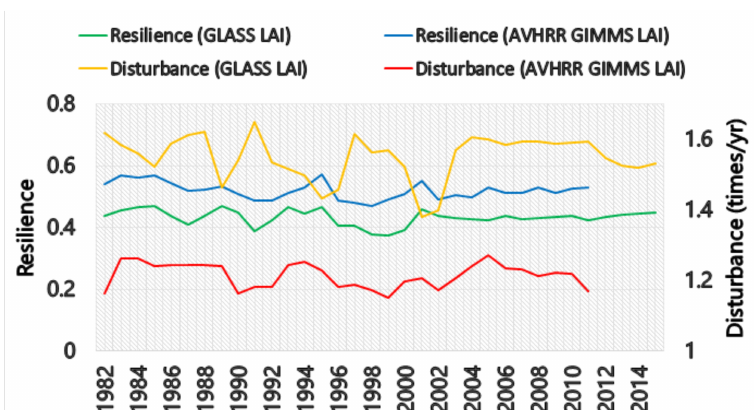
Figure 10. Global soil moisture regime map.